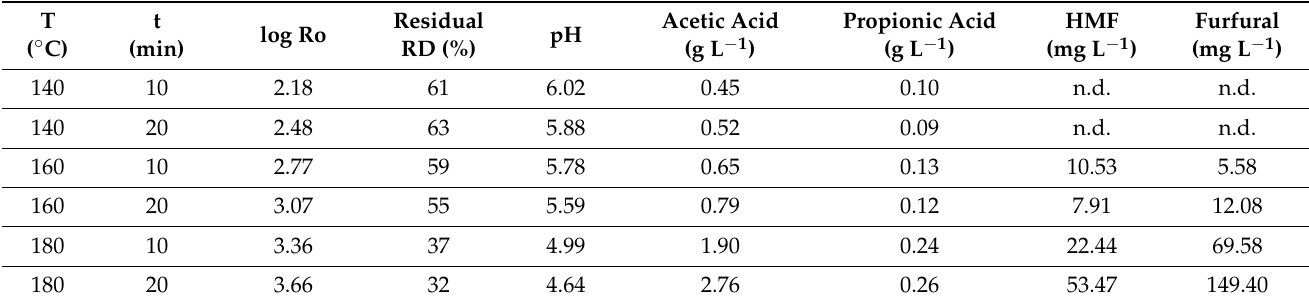
Table 2. Chemical composition of liquid fraction from pretreated rice processing residue.